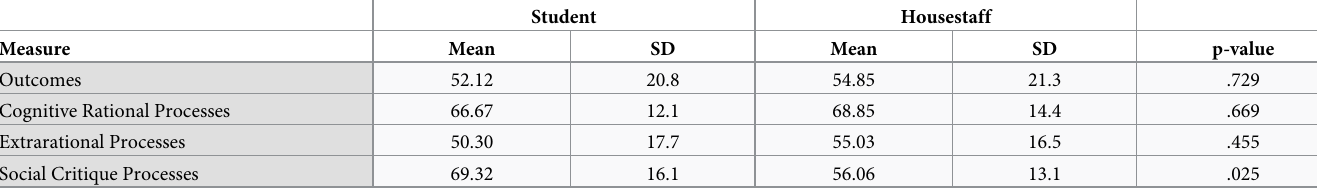
Table 2 depicts the mean TLS scores showing which TL outcomes were most achieved compared to others, as well as which TL processes were most frequently utilized across our entire sample. NOTE: All measures are grouped so that line items can be compared with other line items within the same heading. All measures with the same grouping letter are not significantly different from each other (p > 0.05). Measures not sharing the same grouping letter are significantly different from each other (p � 0.05, two-tailed).